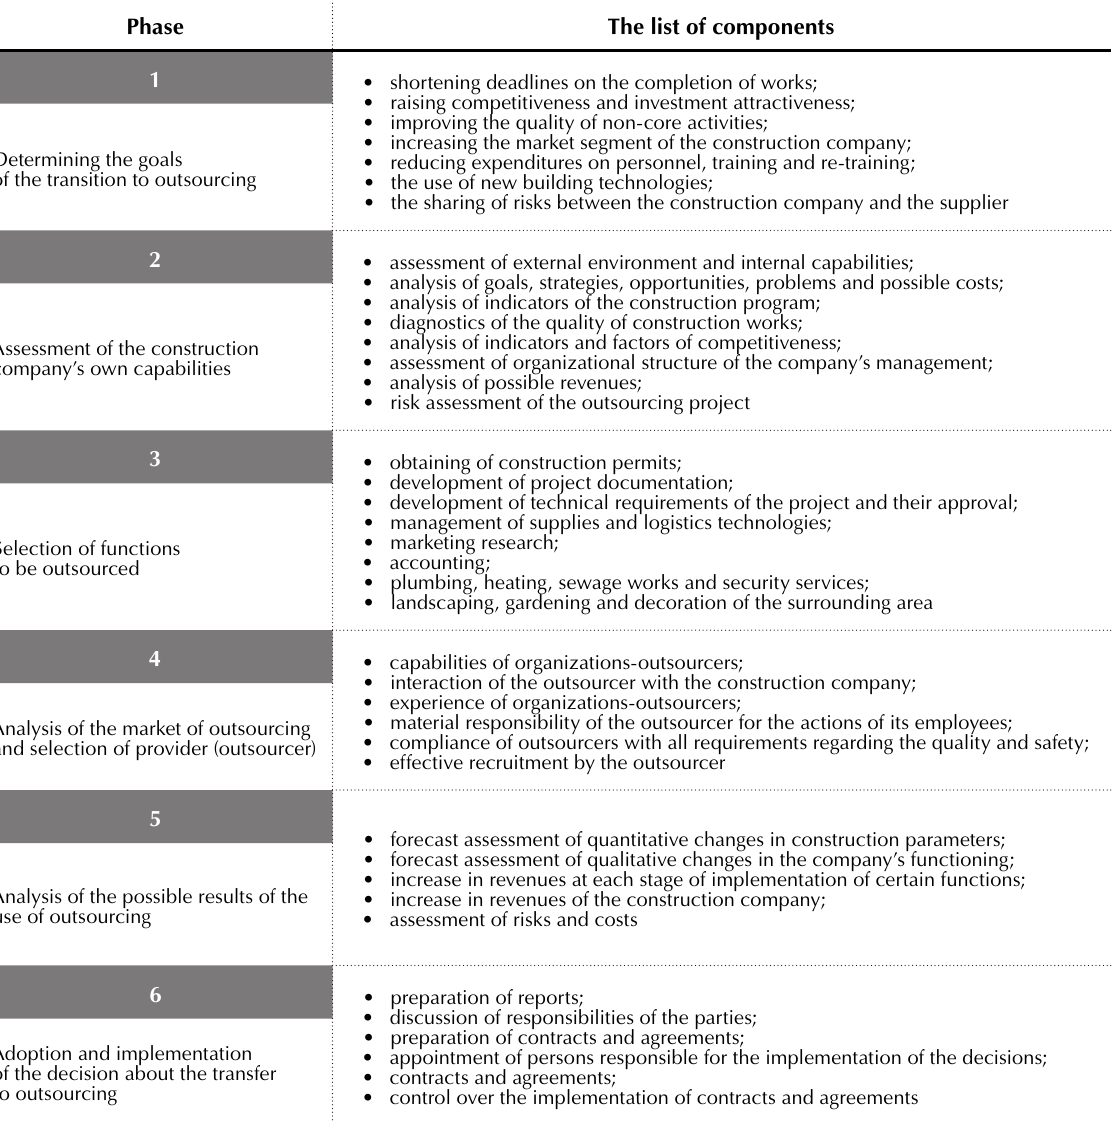
Table 2. The procedure for the transfer of the construction company to outsourcing Phase The list of